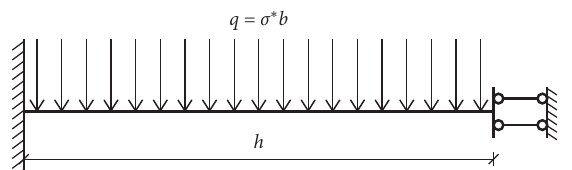
Figure 7: Internal force calculation model of floor corner